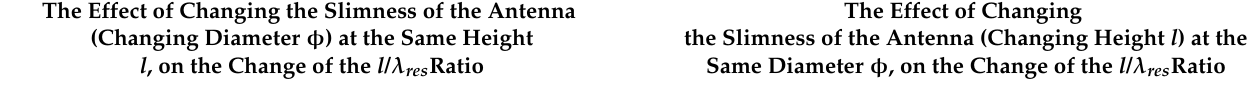
Table 2. Values of resonance points l / λ res of cylindrical antennas. The Effect of Changing The Effect of Changing the Slimness of the Antenna the Slimness of the Antenna (Changing Height l ) at the (Changing Diameter φ ) at the Same Height l , on the Change of the l / λ res Ratio Same Diameter φ , on the Change of the l / λ res